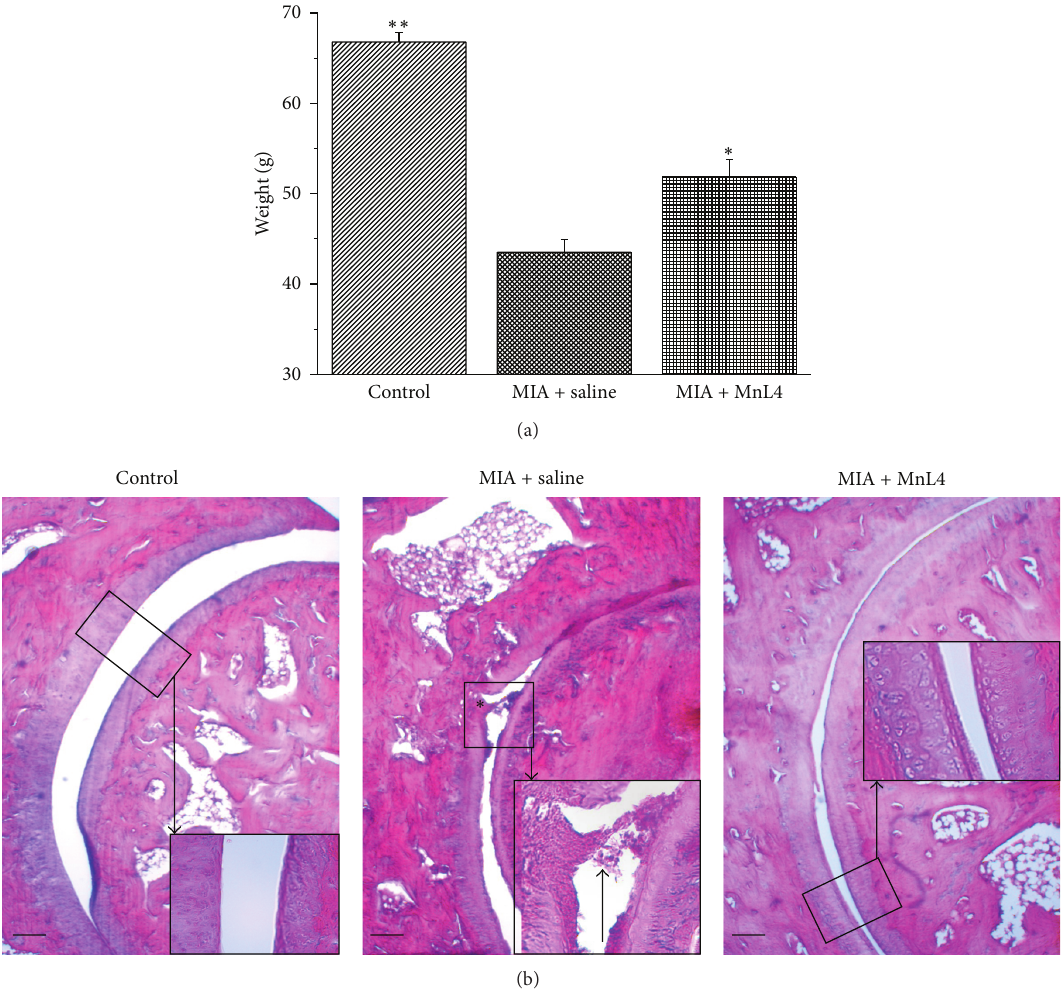
Figure 4: Effect of MnL4 (continuously infused for 15 days) on monoiodoacetate- (MIA-) induced unilateral osteoarthritis. MIA (2mg/25 𝜇 L) was injected in the left posterior tibiotarsal articulation 14 days before the pain evaluation by the paw pressure test. At day 0, a minipump containing MnL4 solution (15 mg kg −1 day ) was implanted on the back of MnL4-treated rats. Values are the mean ± s.e.m. of 5 animals. Panel (a): pain behavior; ∗ 𝑃 < 0.05 and ∗∗ 𝑃 < 0.01 versus MIA + saline. Panel (b): effect of MnL4 (continuously infused for 15 days) on tibiotarsal articulation histopathology on MIA-induced osteoarthritis. Hematoxilin and eosin staining of longitudinal section of tibiotarsal joint. Pictures are representative of histological preparations from 5 animals per group. Bars = 100 𝜇